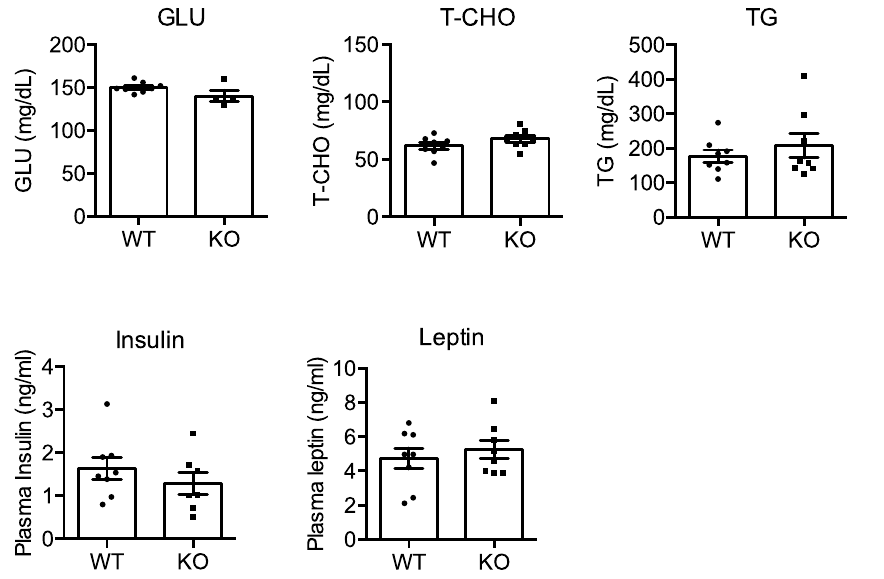
Figure 3. Blood biochemistry of male WT and NMU KO rats fed normal chow. Serum levels of GLU, T-CHO, and TGs were measured by an automatic biochemistry analyzer (n = 8). Plasma levels of insulin and leptin were measured by ELISAs (n = 8). All data represent means ±